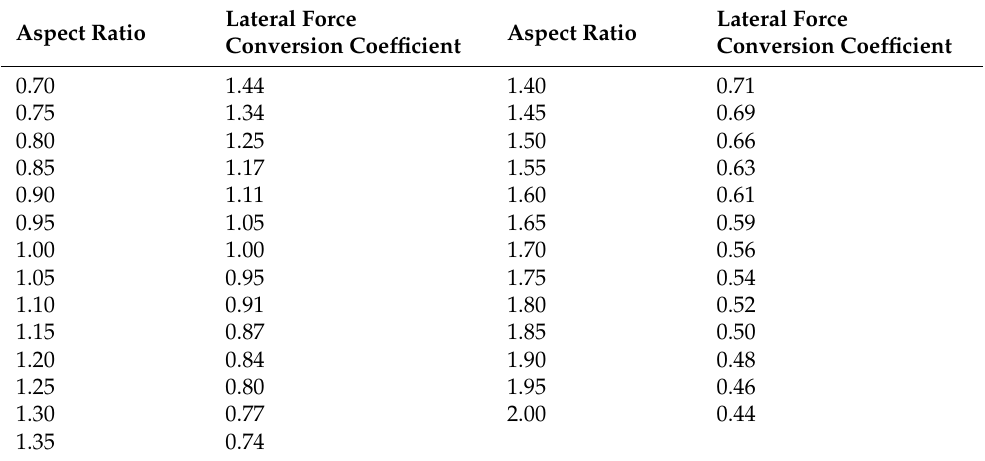
Table 3. Correspondence table of different wall aspect ratios and their lateral force conversion coefficients [34].